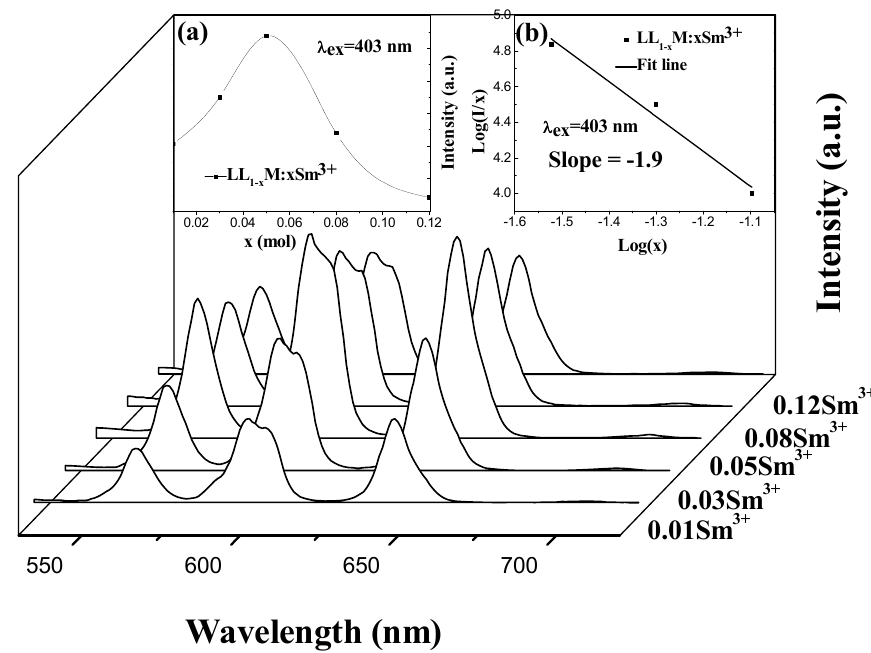
Figure 3. The emission spectra of LL 1 − x M: x Sm 3+ ( x = 0.01, 0.03, 0.05, 0.08, 0.12) under 403 nm excitation. The inset ( a ) shows the relative luminescence intensity at 598 nm as a function of Sm 3+ concentration; and ( b ) shows the relationship of log( I / x ) vs. log( x ) for the LL 1 − x M: x Sm 3+ phosphors.